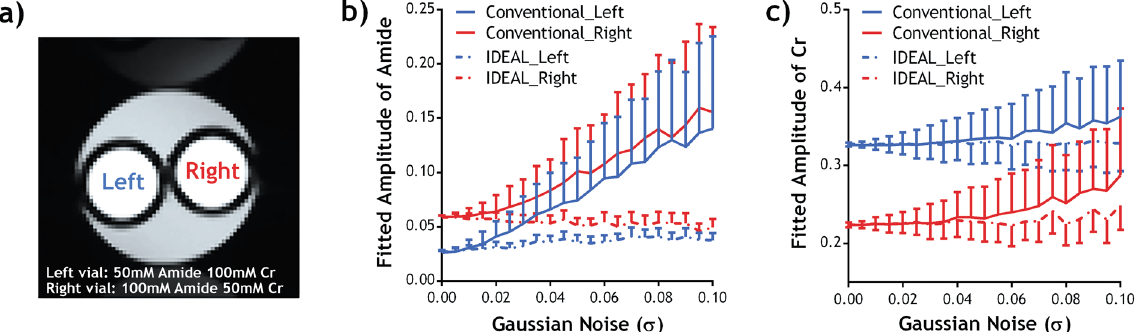
Figure 3. Comparison of fitted amplitudes from conventional fitting and IDEAL fitting under different noise level in ( a ) a phantom with two compartments containing different concentrations of amide and Cr. Fitted amplitudes of ( b ) amide and ( c ) Cr in each compartment was plotted as a function of standard deviation of added Gaussian noise ( σ ).